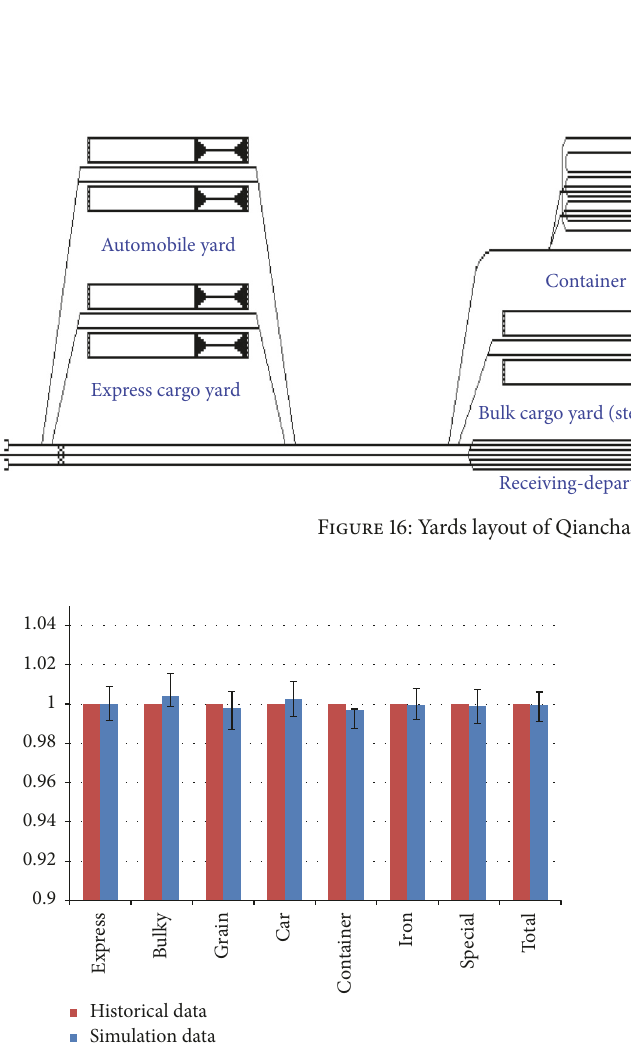
Figure 17: Normalized cargo volumes from historical and simula- tion